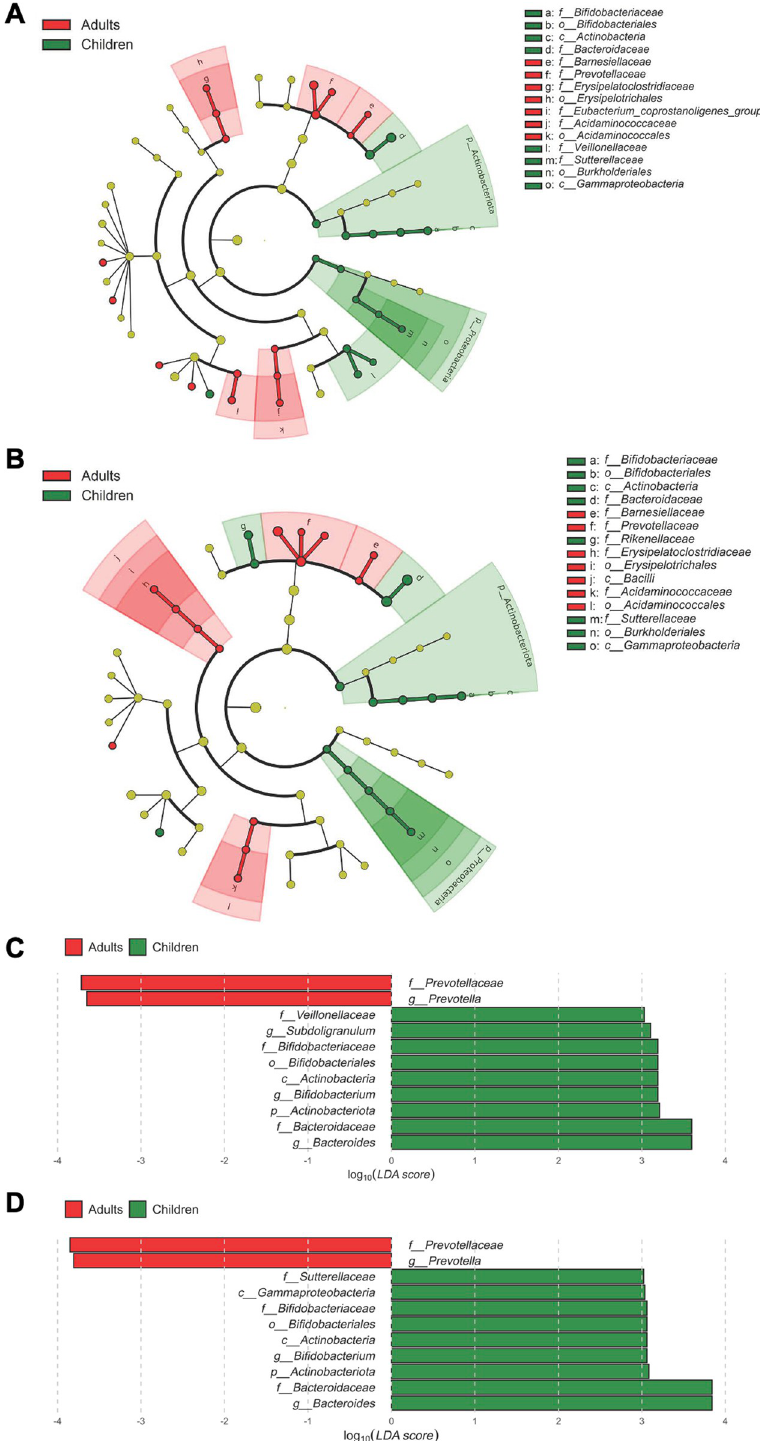
Fig 6. Characterization of microbiomes of adults and children by LEfSe and LDA analysis. A. Taxa with significant differences in abundance between adults and children with Ct kit. B. Taxa with significant differences in abundance between adults and children with Qia kit. Histogram of log 10 (LDA scores) for features with differential abundance between adults and children with Ct kit (C) and with Qia kit (D). Taxa of |log 10 (LDA scores)| > 3 are presented.